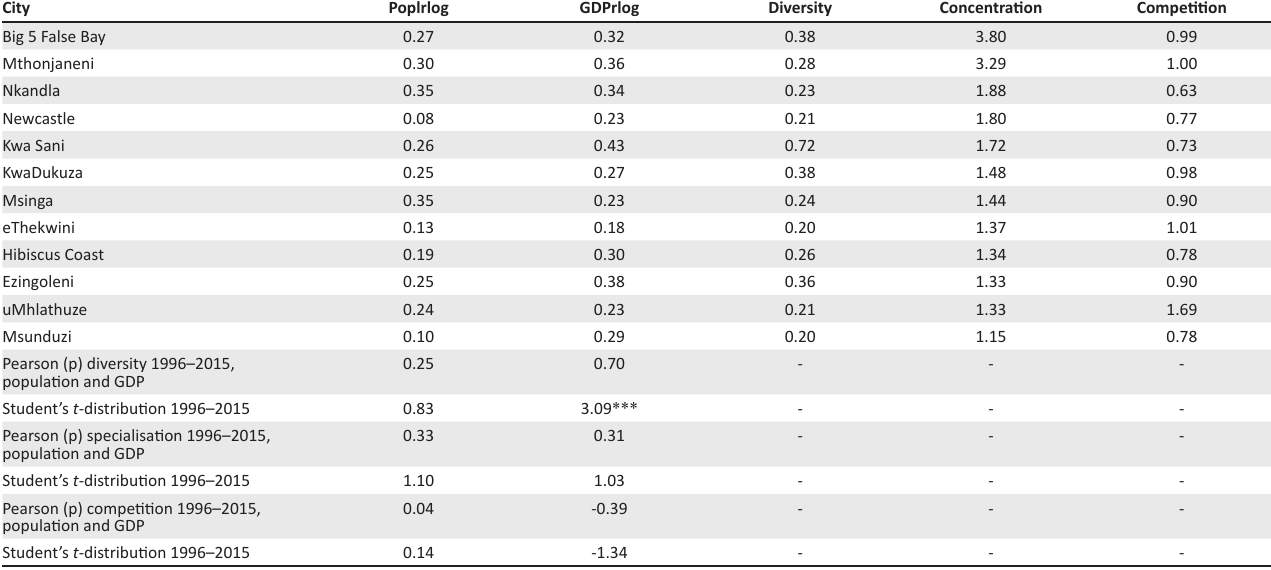
TABLE 9: City growth specialisation, diversity and competition in KwaZulu-Natal cities, 1996 to 2015. City Poplrlog GDPrlog